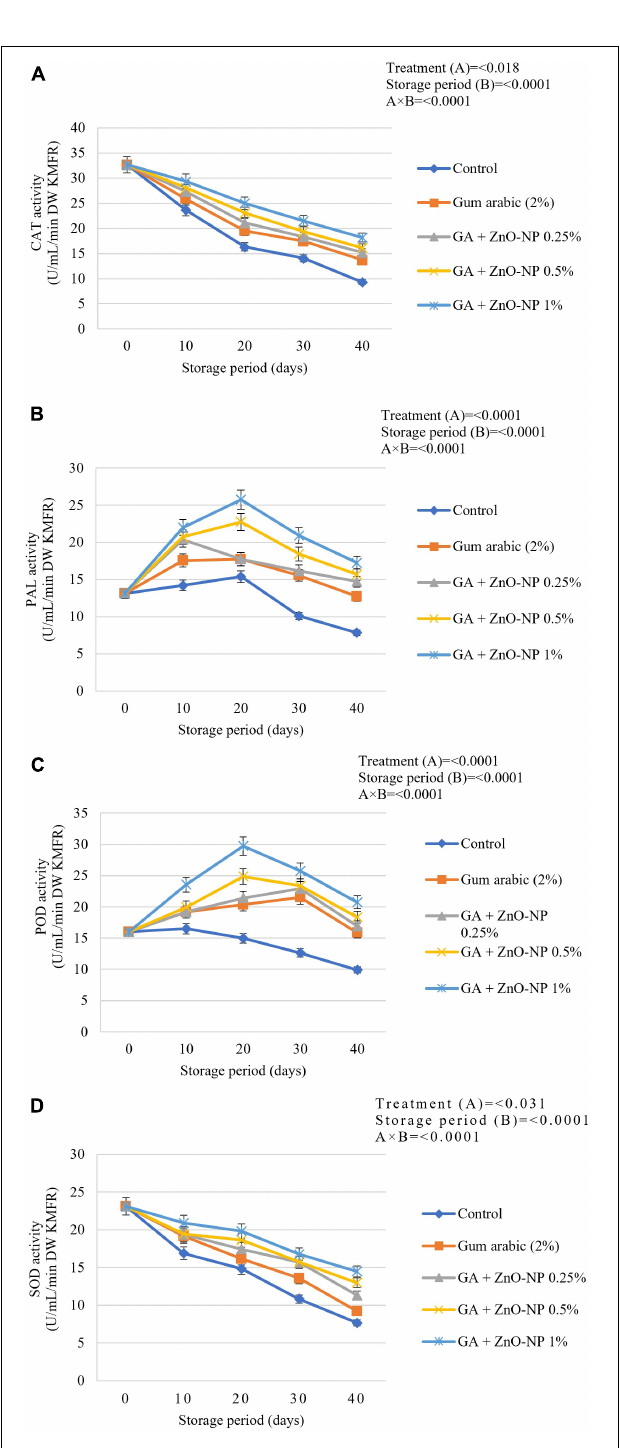
FIGURE 9 | (A) Catalase (CAT), (B) phenylalanine ammonia-lyase (PAL), (C) peroxidase (POD), and (D) superoxide dismutase (SOD) antioxidant activity of ‘Kinnow’ mandarin fruit during storage for 40 days at 5 ± 1 ◦ C and additional 5 days at 20 ± 5 ◦ C. Error bars denote the standard error (SE) of the mean. Means ± standard errors presented. To determine the interaction effects, factorial ANOVA was performed for the main factors, treatment, and storage time. GA + ZnO-NP, gum arabic + zinc oxide nanoparticles; DW, dried weight; KMFR, ‘Kinnow’ mandarin fruit